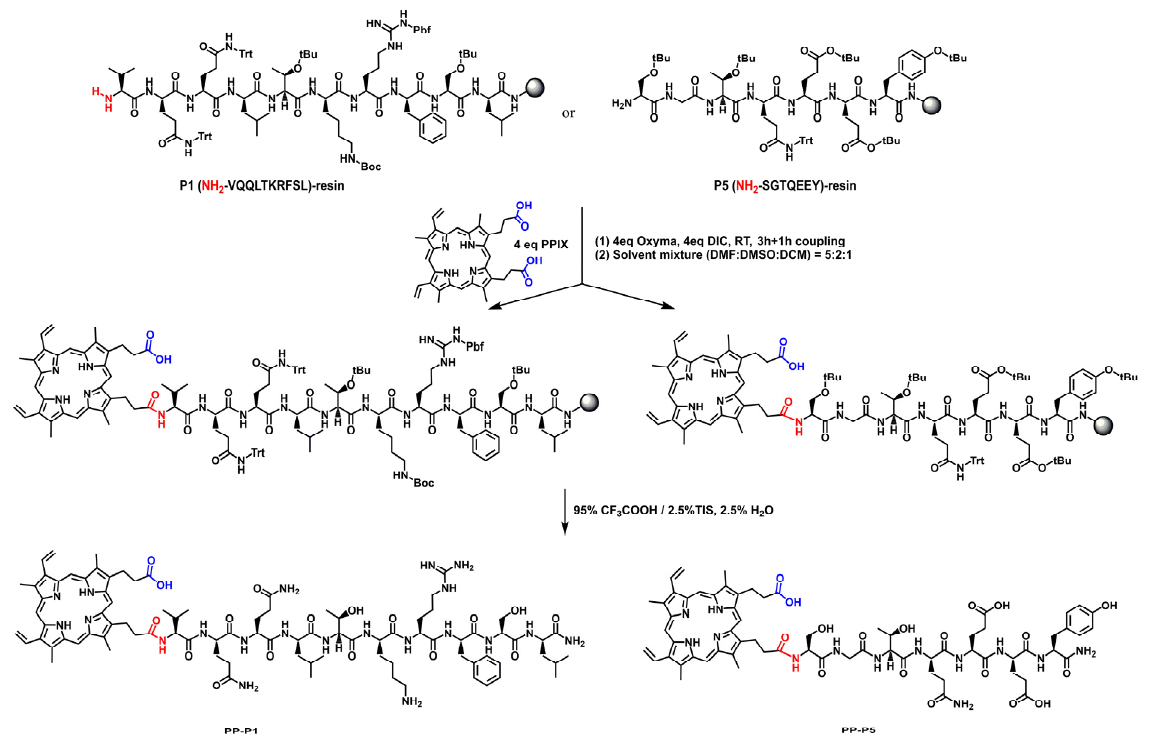
Table 1. PPCs used in the